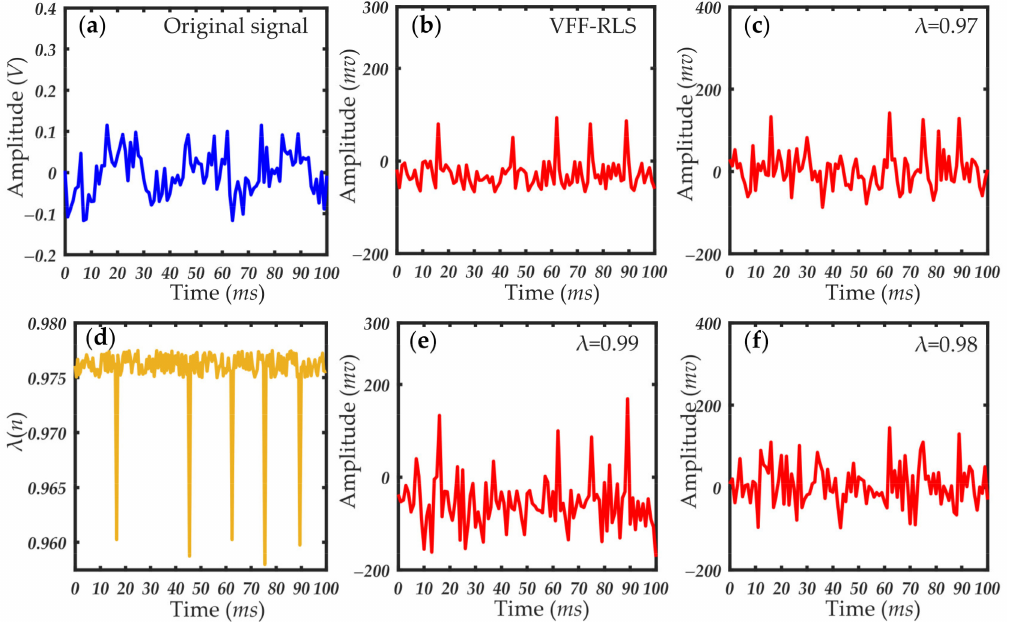
Figure 8. Particle scattering signal and filtering results (particle size: 0.5 µ m): ( a ) original scattering signal; ( b ) particle scattering signal processed by the VFF-RLS algorithm; ( d ) change curve of forgetting factor; ( c , e , f ) results of RLS algorithm with fixed forgetting factors, which are 0.97, 0.99, and 0.98,